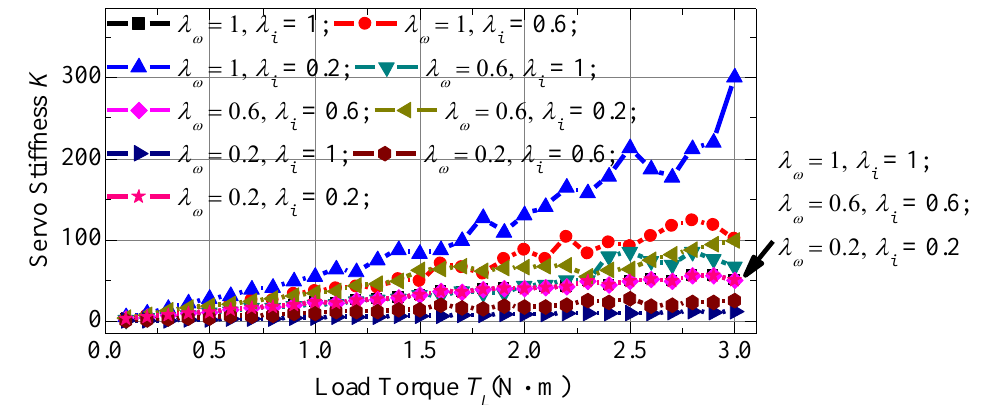
Figure 11. Servo stiffness with different weighting factors for the proposed